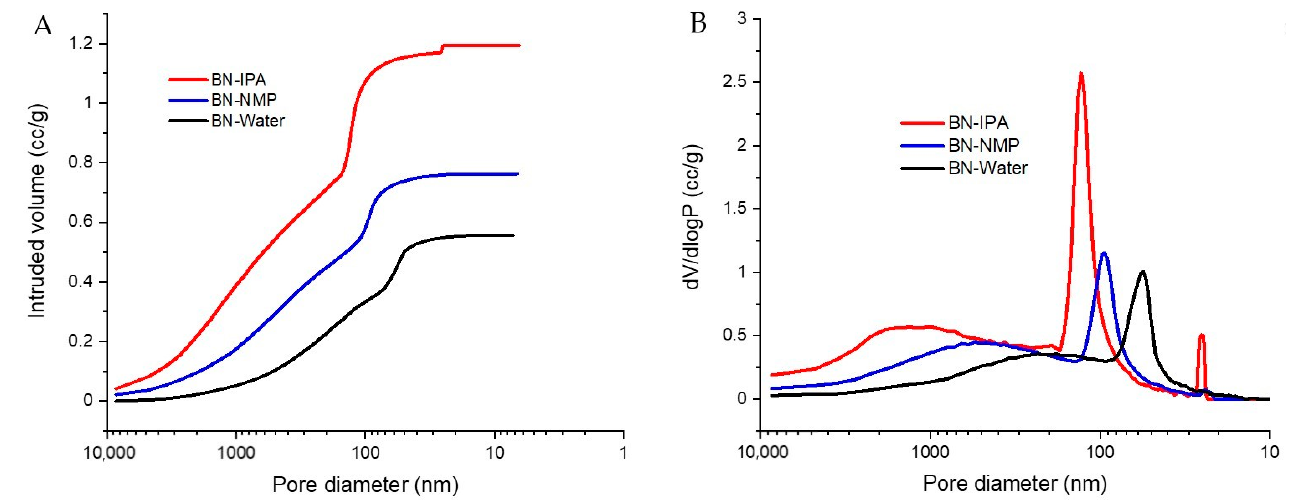
Figure 8. Comparison of mercury intrusion characteristics of the BN membrane samples ( A ) and ( B ) comparison of mercury pore size distributions of the BN membrane samples.